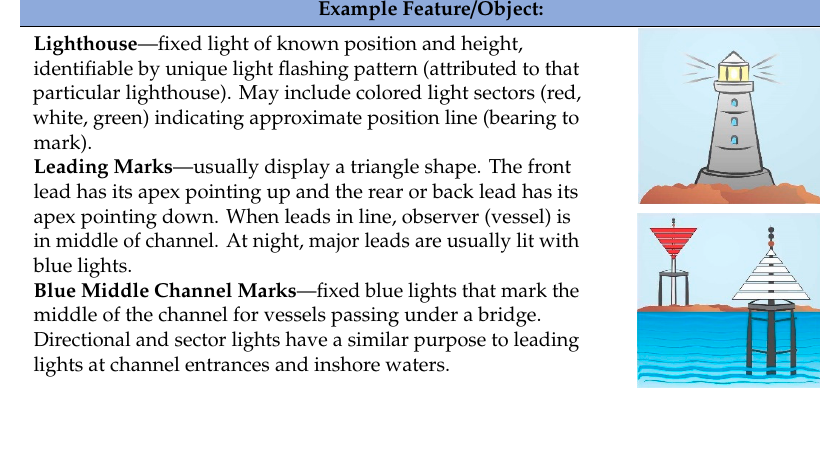
Table 1. Identifying objects in night environment conditions.